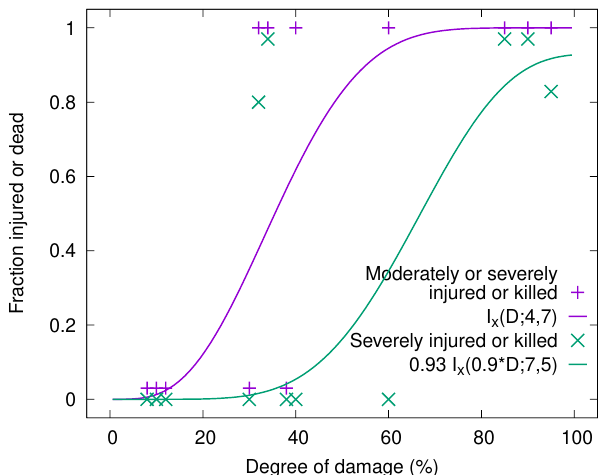
Figure 11. Vulnerability data from two avalanche events. The data points with D = 0.6 and D = 0.95 are from the game room and lobby of Hotel Rigopiano, respectively, the other 11 sets of two points with equal D are from each of the houses hit by the 19 December 2015 Longyearbyen avalanche [10]. Where data points would overlap, they were slightly shifted. The full curves were fitted visually with incomplete Beta functions and are only meant to guide the